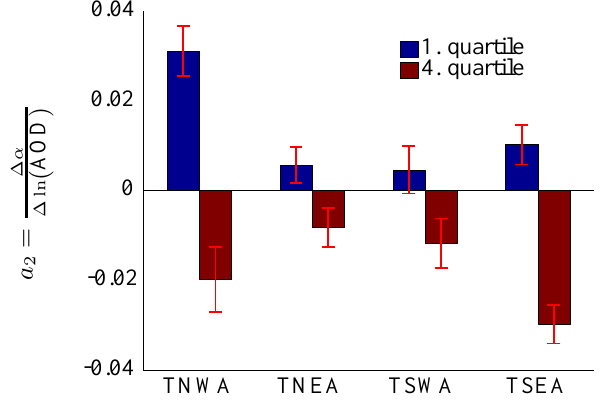
Fig. 3. Result from the regressions analysis using GEMS-reanalysis data instead of the UV-AI (Sect. 3.3): coefficients a 2 in Eq. (1) and Fig. 3: Result from the regressions analysis using GEMS-reanalysis respective standard deviations for the selected data instead of the UV-AI (Sec. 3.3): coefficients a 2 in Eq.1 and respective standard deviations for the selected regions.